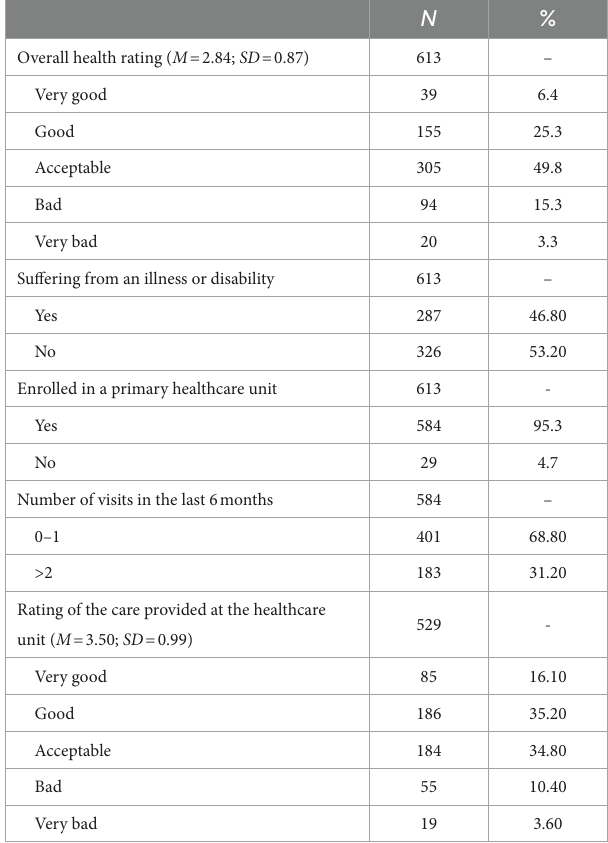
TABLE 1 Sociodemographic characteristics. TABLE 2 Health-related